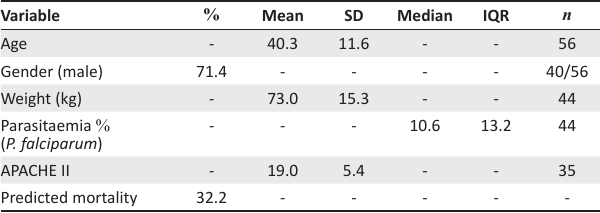
TABLE 1: Patients